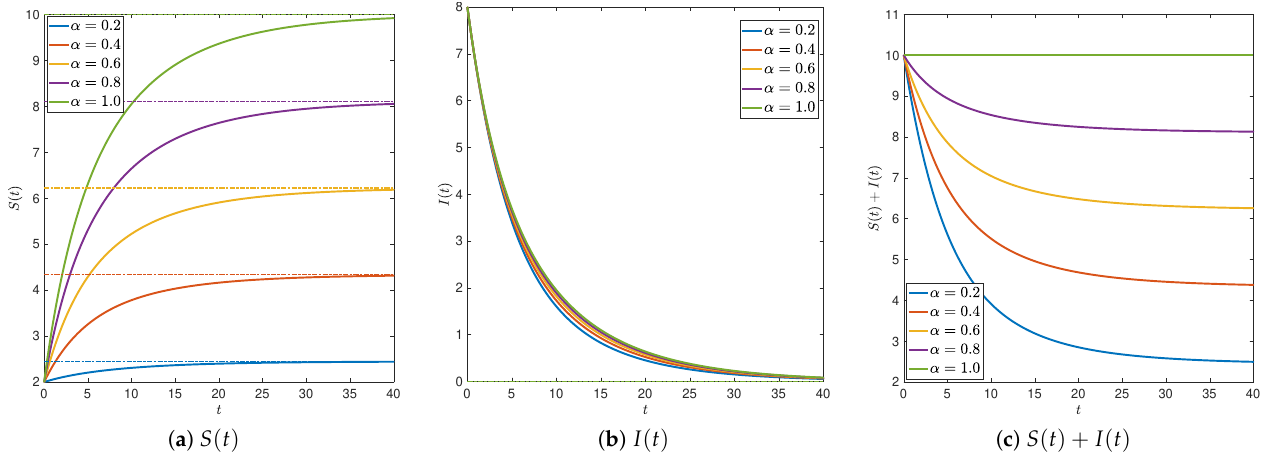
Figure 4. Numerical solutions to (2) with β = 0.1, γ = 0.2, S 0 = 6, I 0 = 4, and M ( α ) ≡ 1 as α